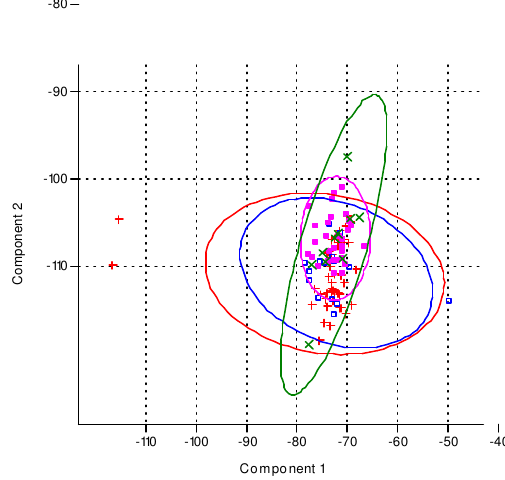
Fig. 2. PCA loadings of morphometrics of wild and cultured samples of Clarias gariepinus